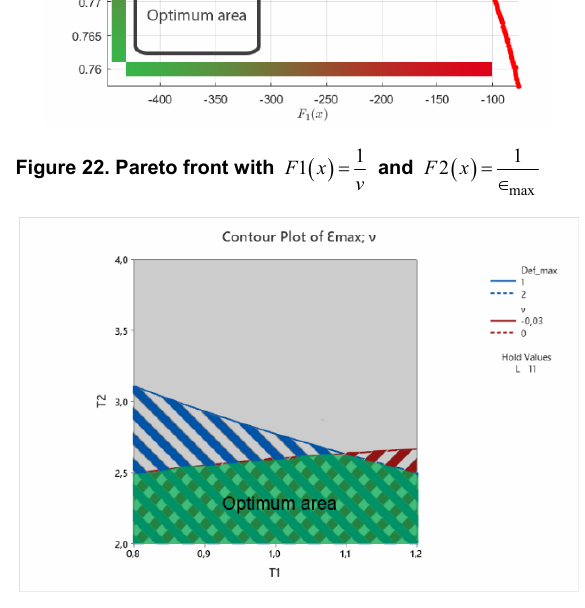
Figure 23. Contour plot of ν ; max ∈